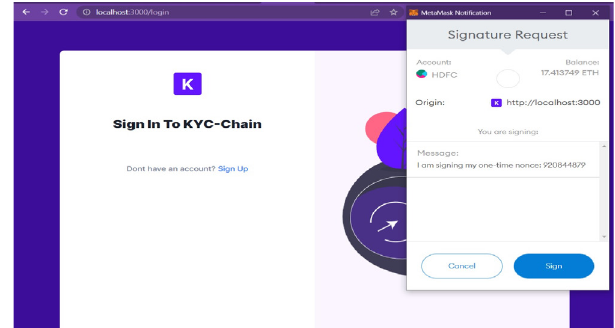
Fig 5. Login screen of the eKYC